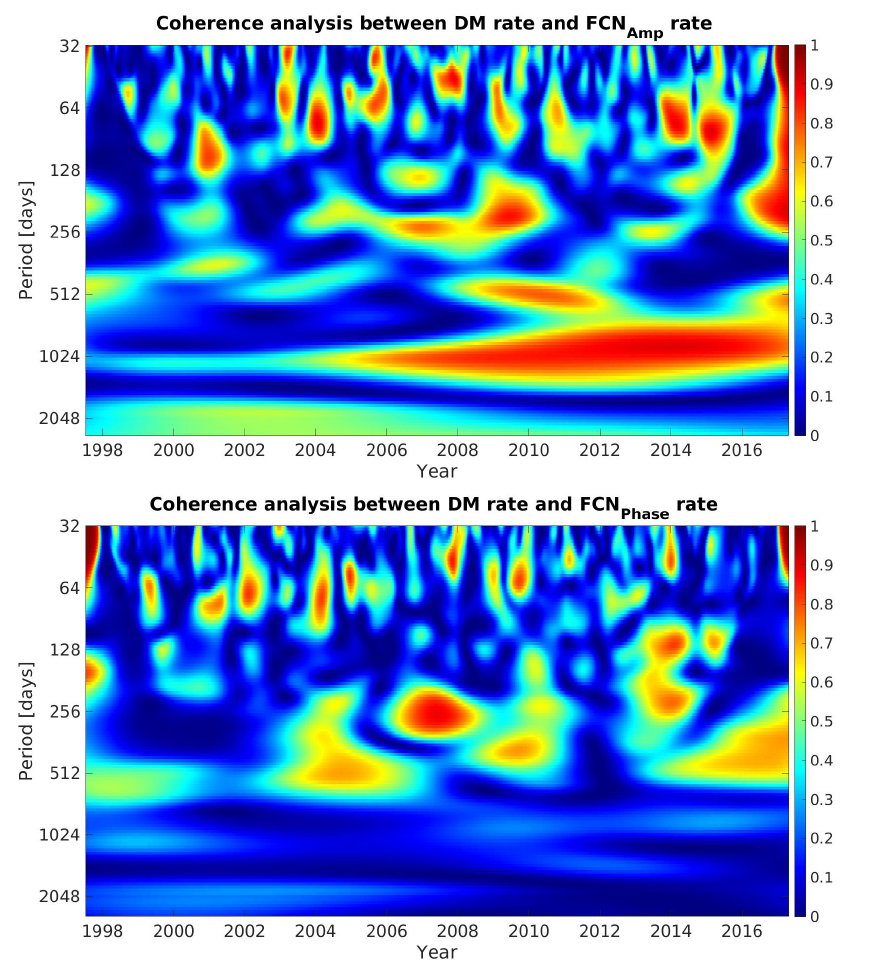
Figure 9. Wavelet coherence between FCN (amplitude and phase) rate and DM